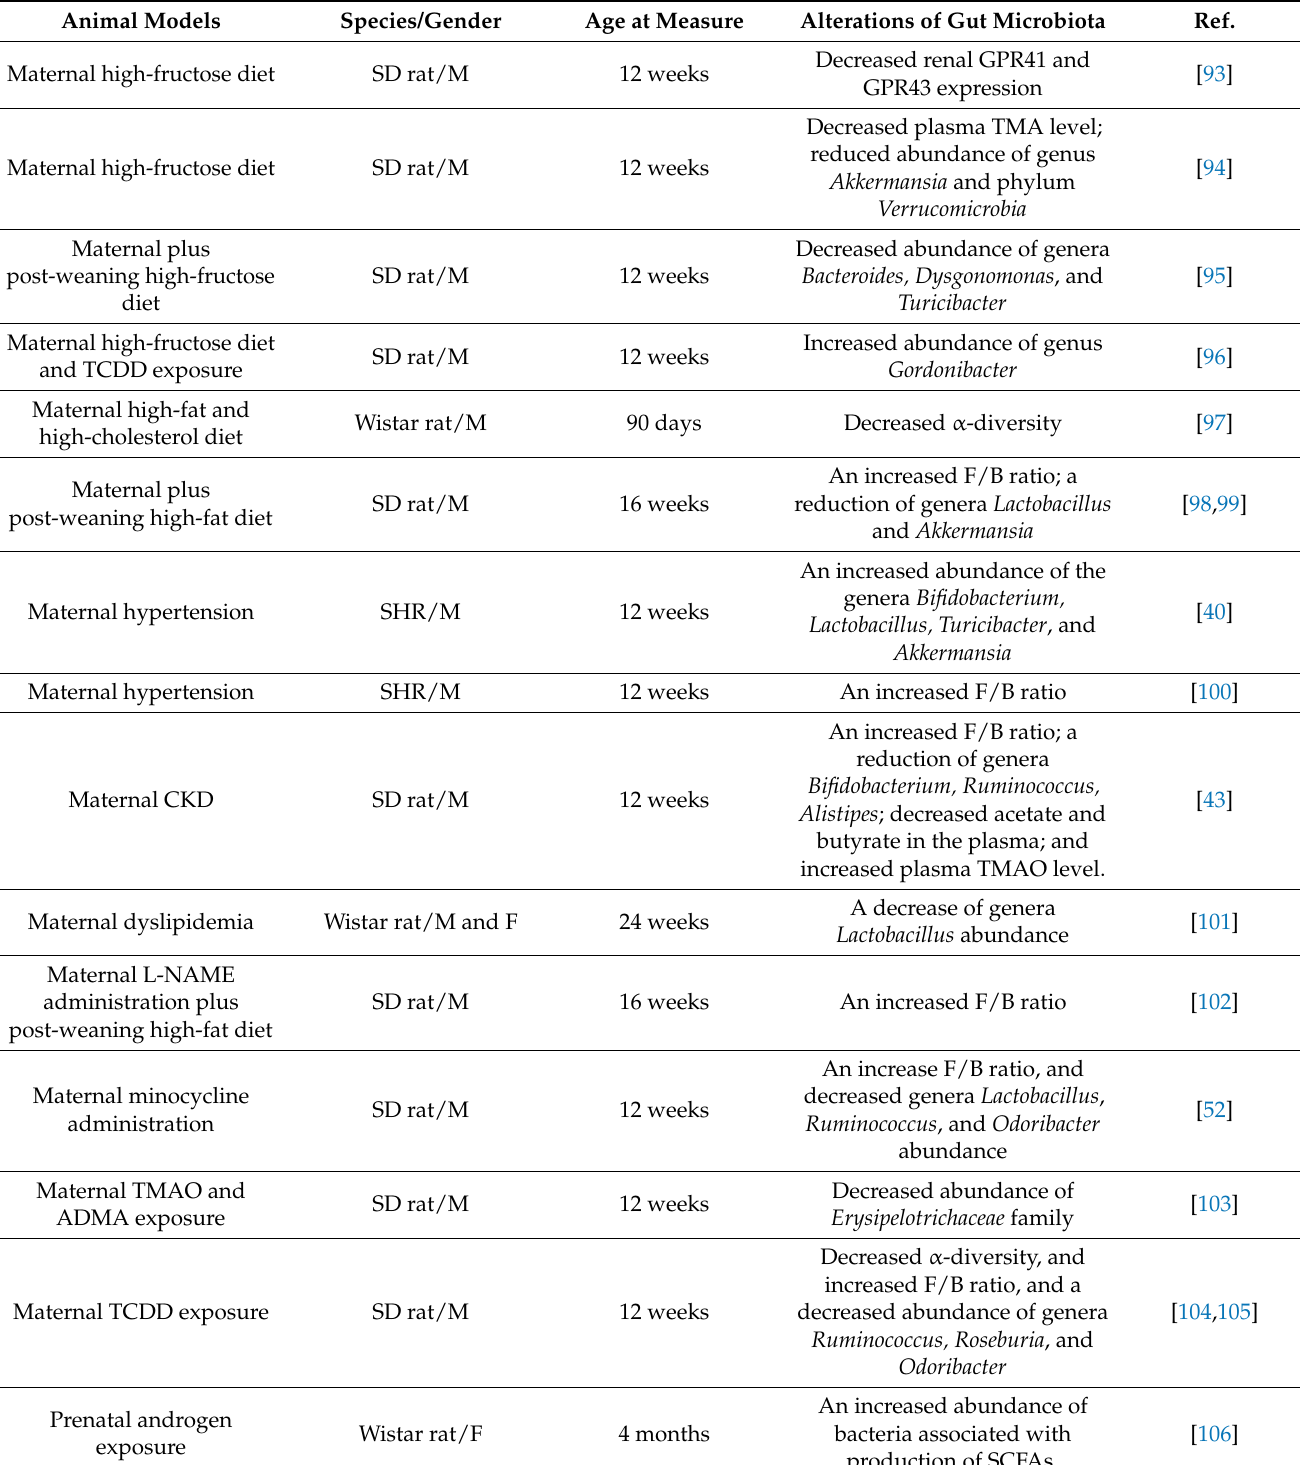
Table 1. Animal models reporting hypertension of developmental origins associated with dysbiotic gut